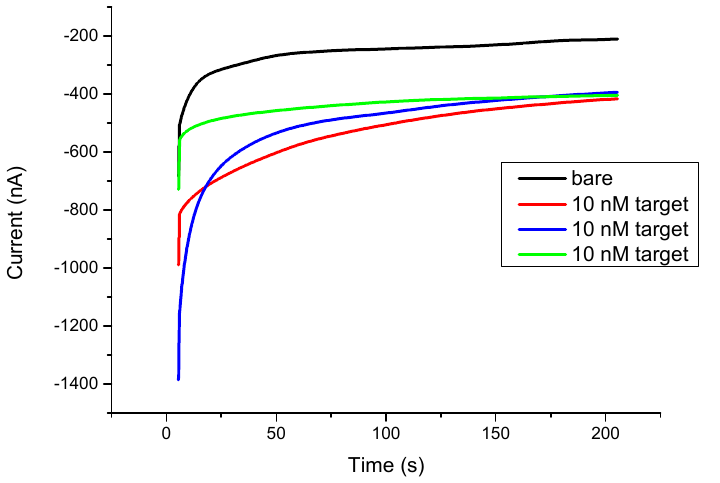
Figure 1. A stability triple repeat test of the miR-21 biosensor against 10 nM of miR-21, recorded with chronoamperometry.